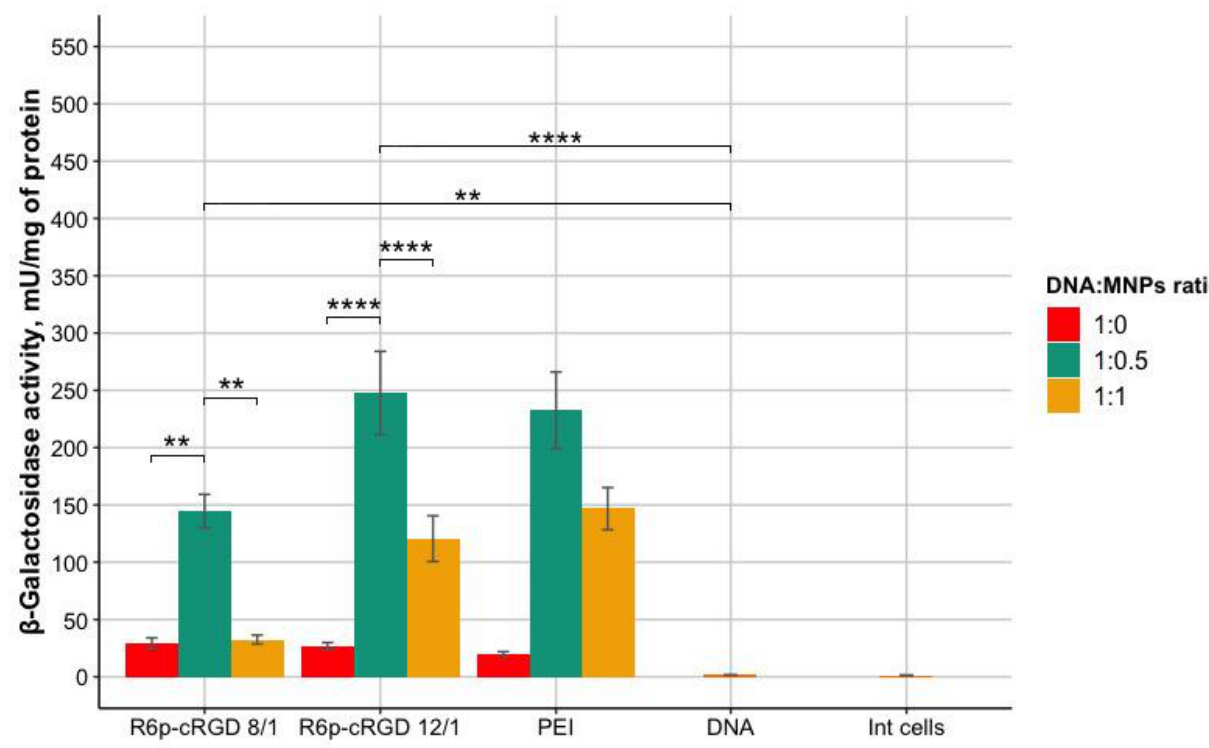
Figure 6. Activity of β -galactosidase in PANC-1 cells after transfection with pCMV-lacZ polyplexes with MNPs. The results are presented as mean and S.E.M. Cells transfected with R6p-cRGD/DNA/MNPs were compared to unpacked DNA; statistical significance was assessed by ordinary one-way ANOVA with Sidak ’ s multiple comparisons test (n = 9; ** 0.01, **** 0.0001).